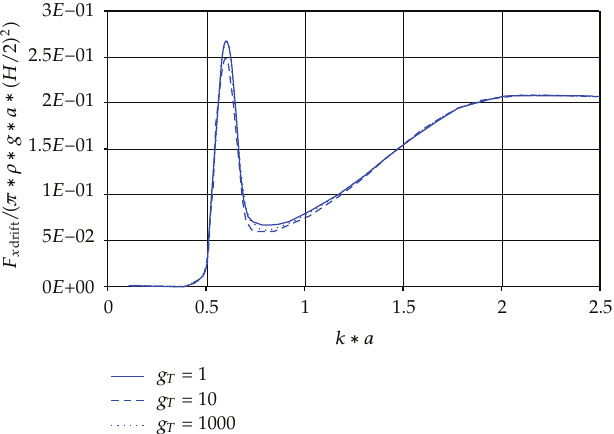
Figure 11: Horizontal mean second-order wave drift forces against k · a for various turbine parameters g T (cid:8) 1,10, 1000 (cid:4) m 5 / (cid:4) N · s (cid:5)(cid:5) .